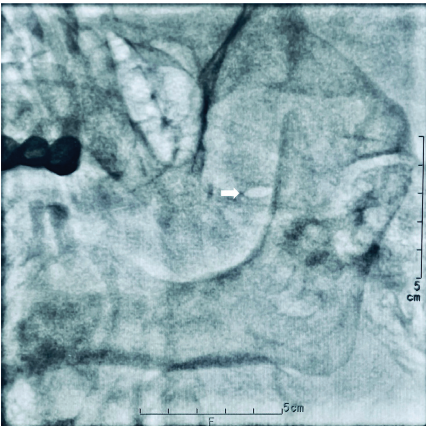
Figure 1: The image showed the oval foramen, located at the upper third of the mandibular ramus, inside of the condyle, penetrating the ophthalmic branch of the trigeminal ganglion toward the medial corner of the oval foramen (arrow).